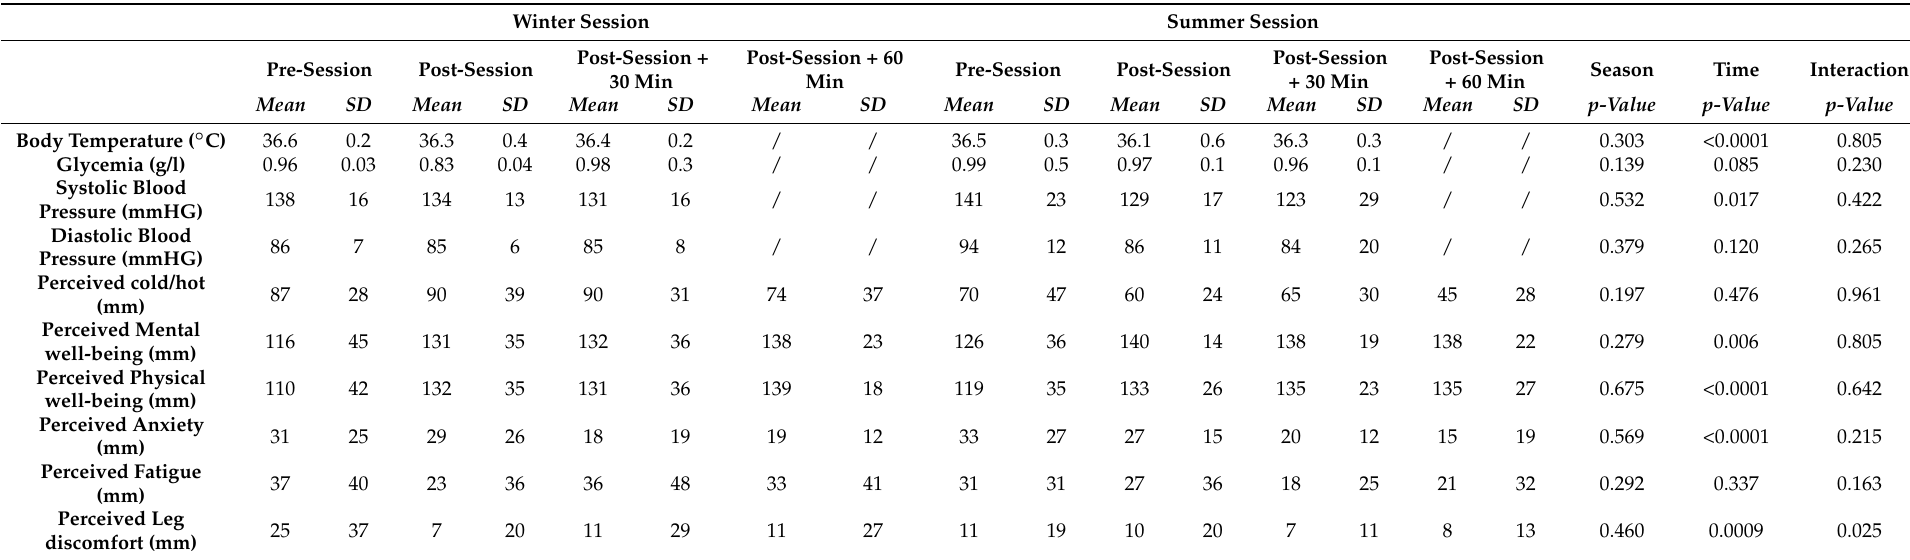
Table 1. Evolution of the metabolic and psychometric variables during the Aqua walking session performed in winter and